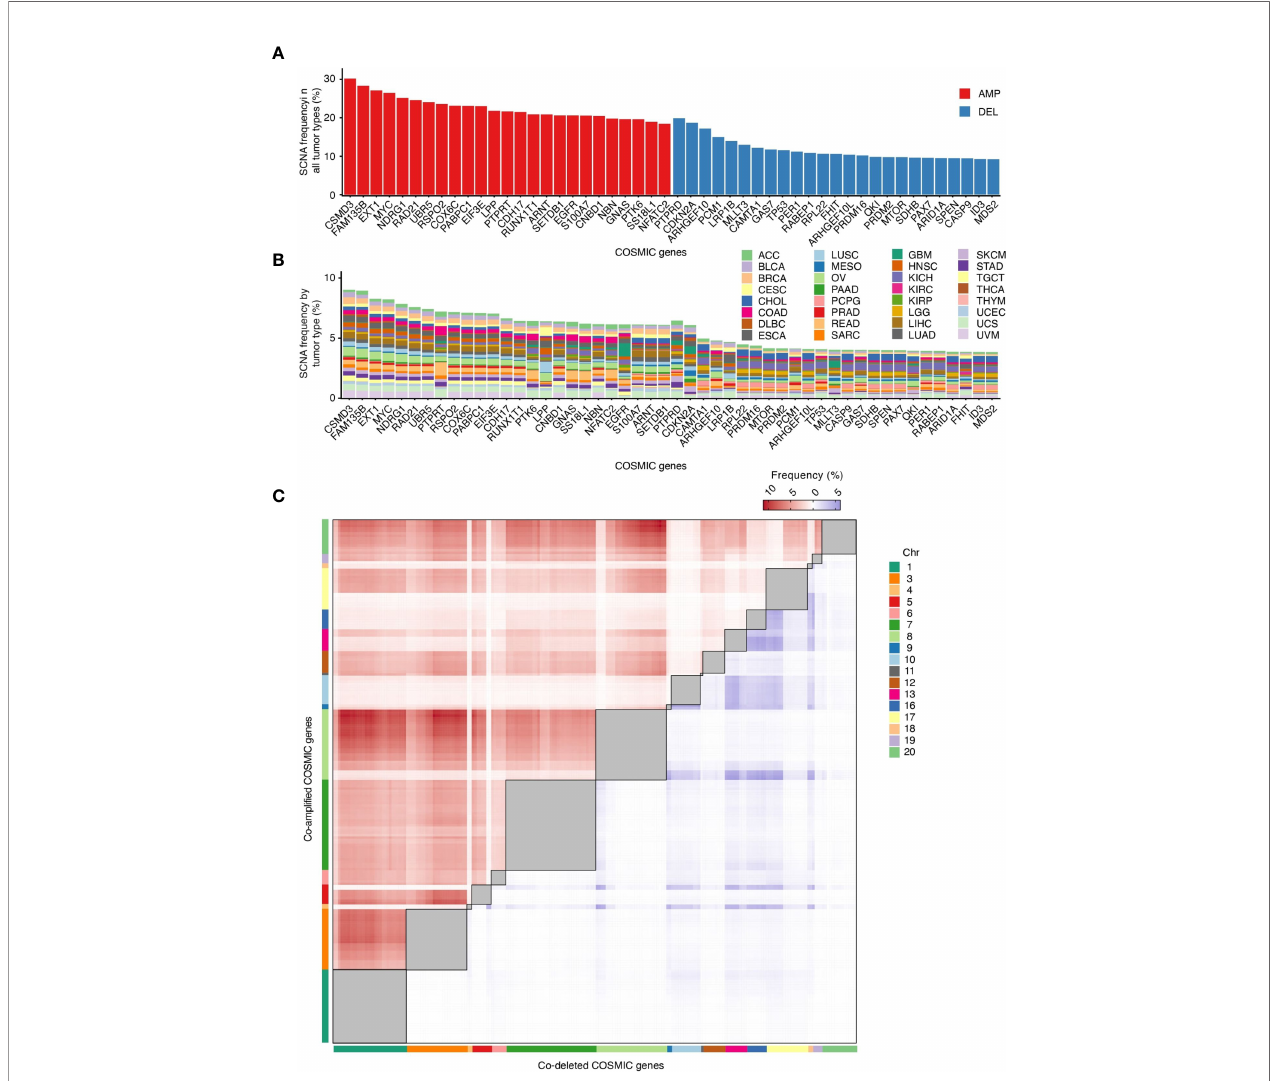
FIGURE 3 | COSMIC genes most frequently affected by SCNAs. (A) Percentage of all tumor types in which the 25 most frequently ampli fi ed (red) and deleted (blue) COSMIC genes are altered. (B) Percentage of tumors in which each COSMIC gene shown in (A) is altered in each of the 32 tumor types analyzed. (C) Frequency of COSMIC gene pairs that are either co-ampli fi ed (red) or co-deleted (blue) in at least 5% of all the 10,729 tumors analyzed. Intra-chromosomal pairs, which are the majority, are masked (grey squares) to make the inter-chromosomal pairs visible. The full list of inter-chromosomal pairs (including AMP-DEL events) sorted by tumor type is available in Supplementary Table 2